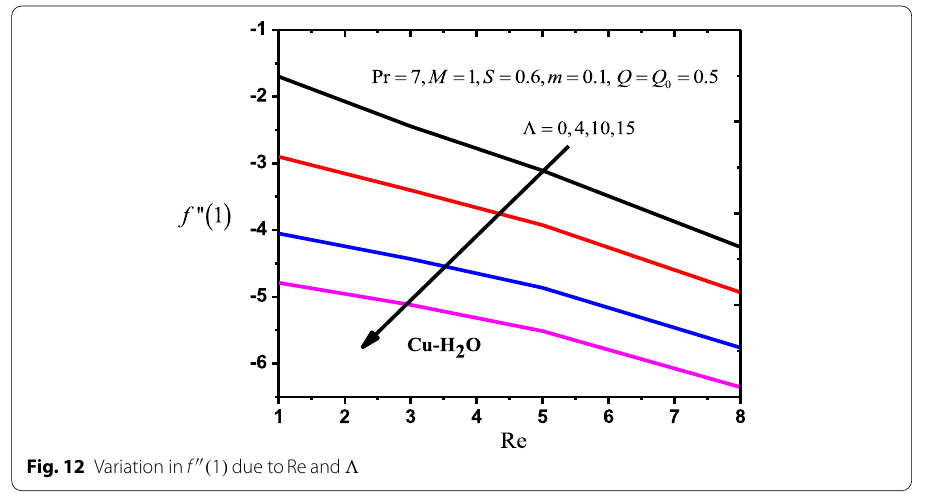
Fig. 12 Variation in f ′′ ( 1 ) due to Re and (cid:31)